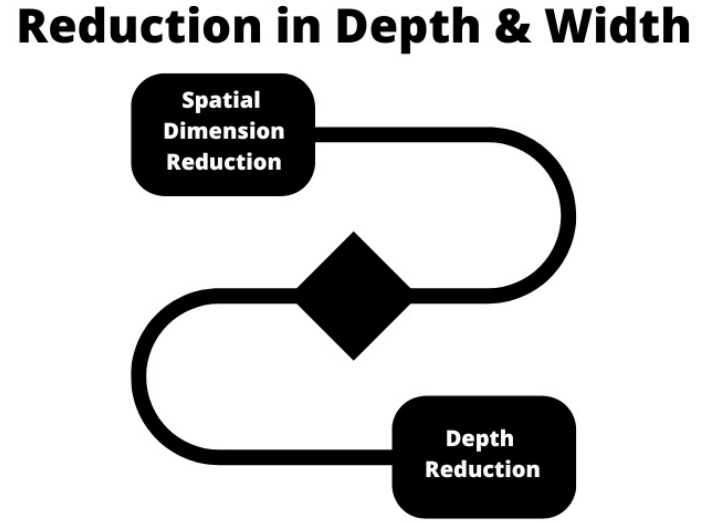
Figure 12. Reduction in Depth and Width.